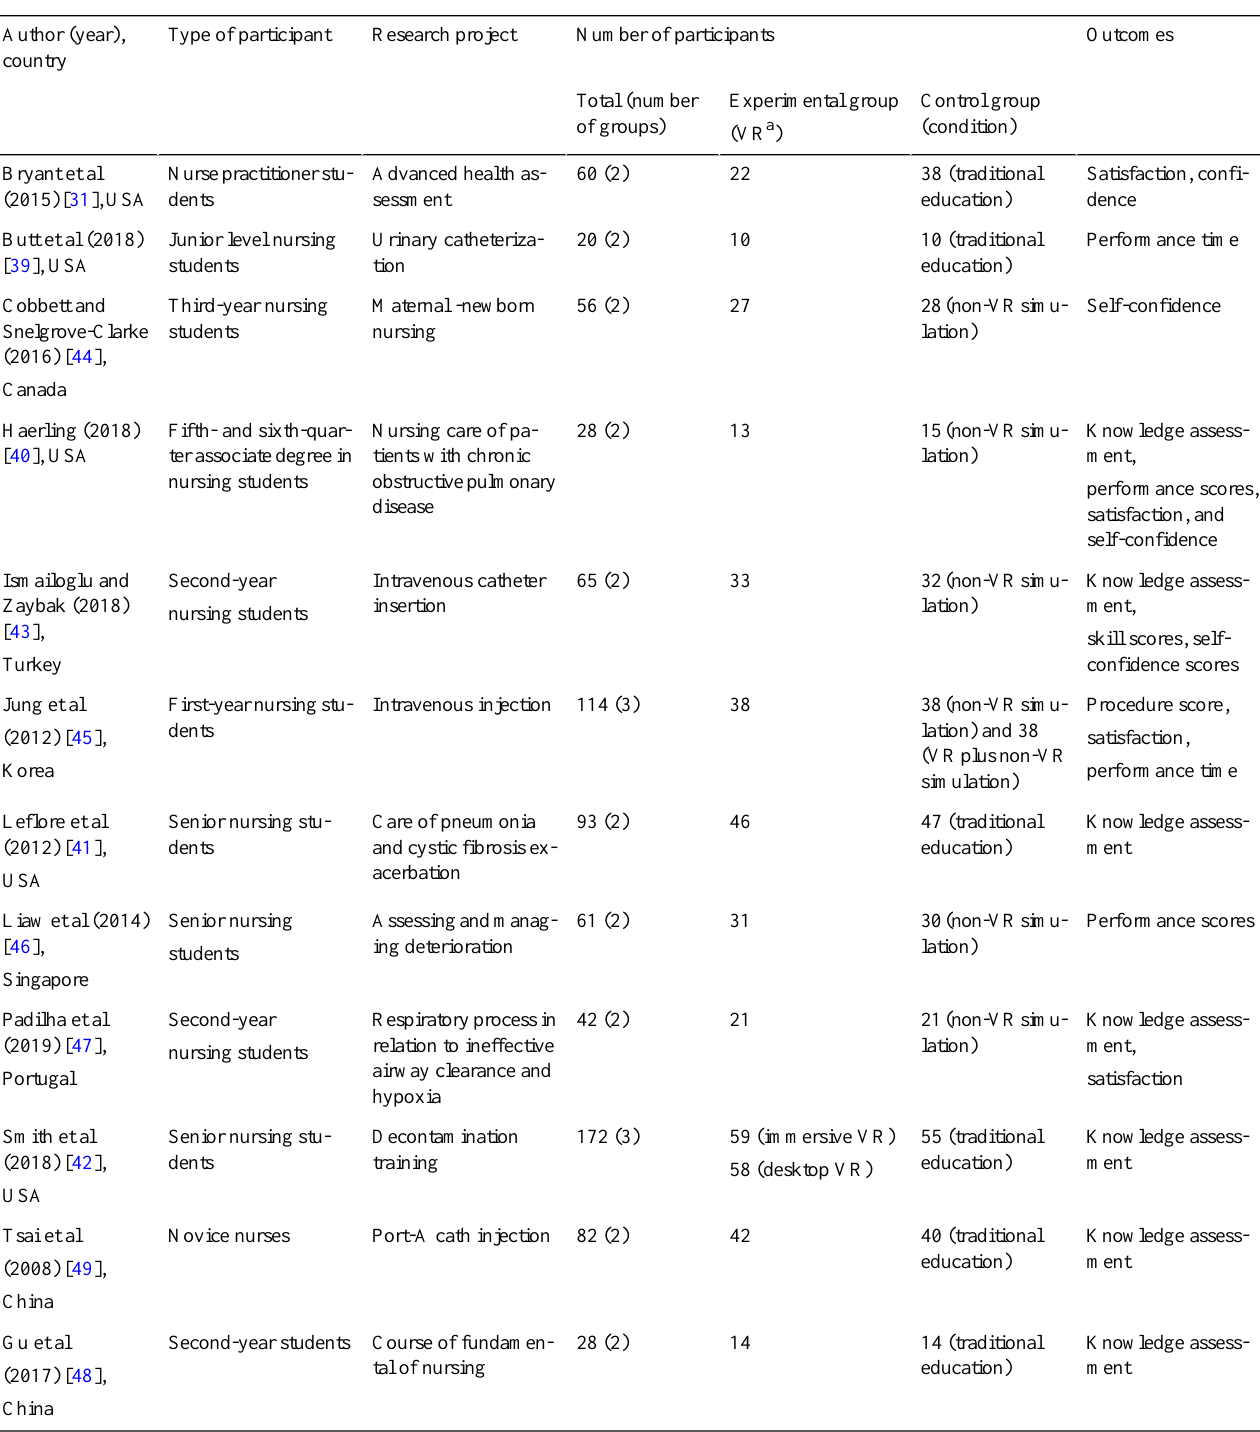
Table 1. Characteristics of the 12 included